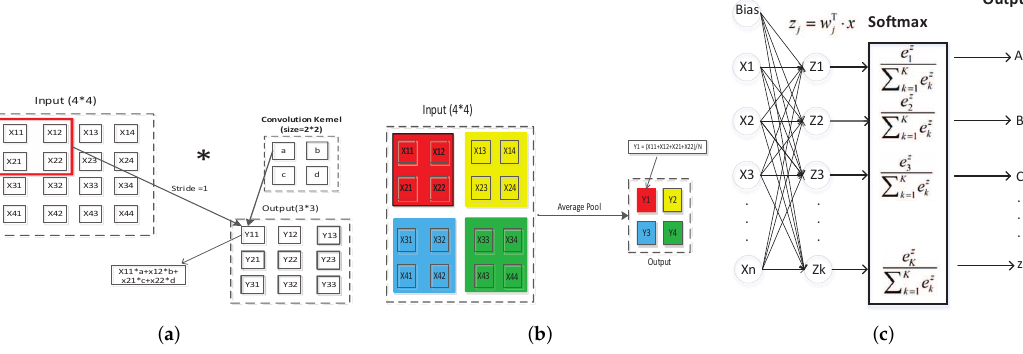
Figure 4. The schematic diagram of layers of CNNs. ( a ) An example of convolution layer with a 3 × 3 kernel; ( b ) An example of average-pooling layer; ( c ) The structure of fully-connected layer, softmax layer and classification